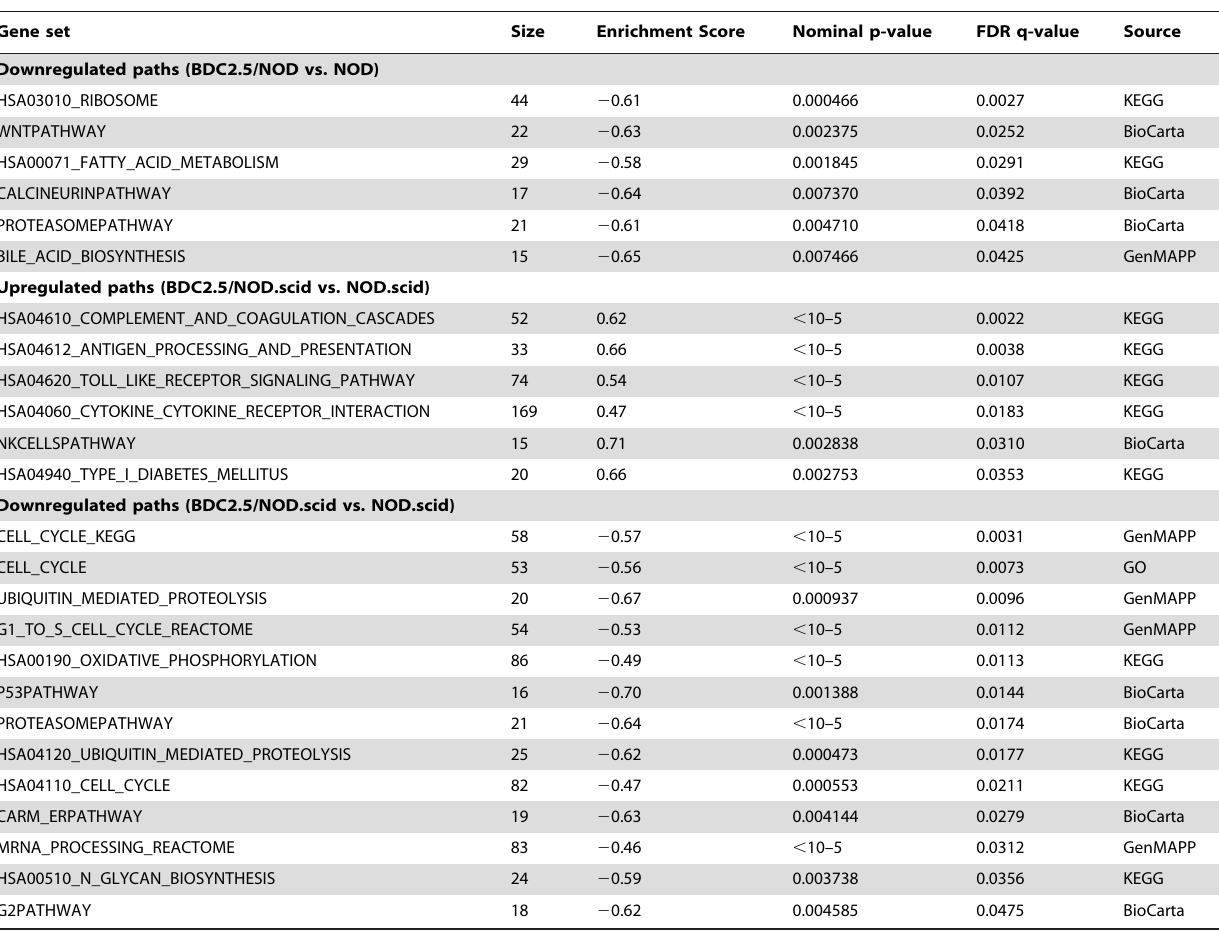
Table 2. Top scored pathways in GSEA.